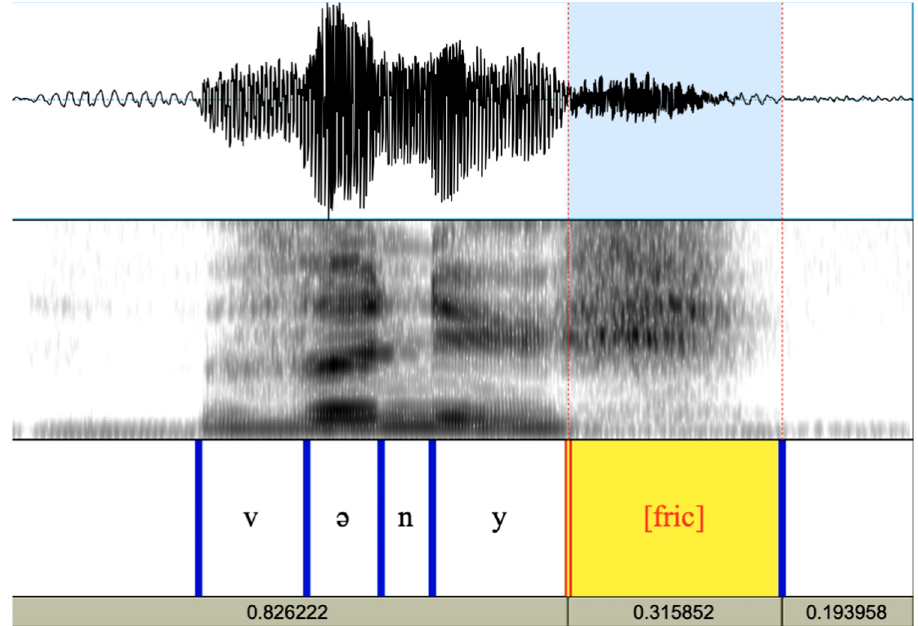
Figure 1. PFFE on the spectrogram: venu ‘came.’ The PFFE corresponds to the final, highlighted segment—characterized by the lack of a voicing band on the spectrogram and aperiodic energy on the waveform—which follows the articulation of the vowel [y], distinguished by its full formant structure on the spectrogram and periodic energy on the waveform.